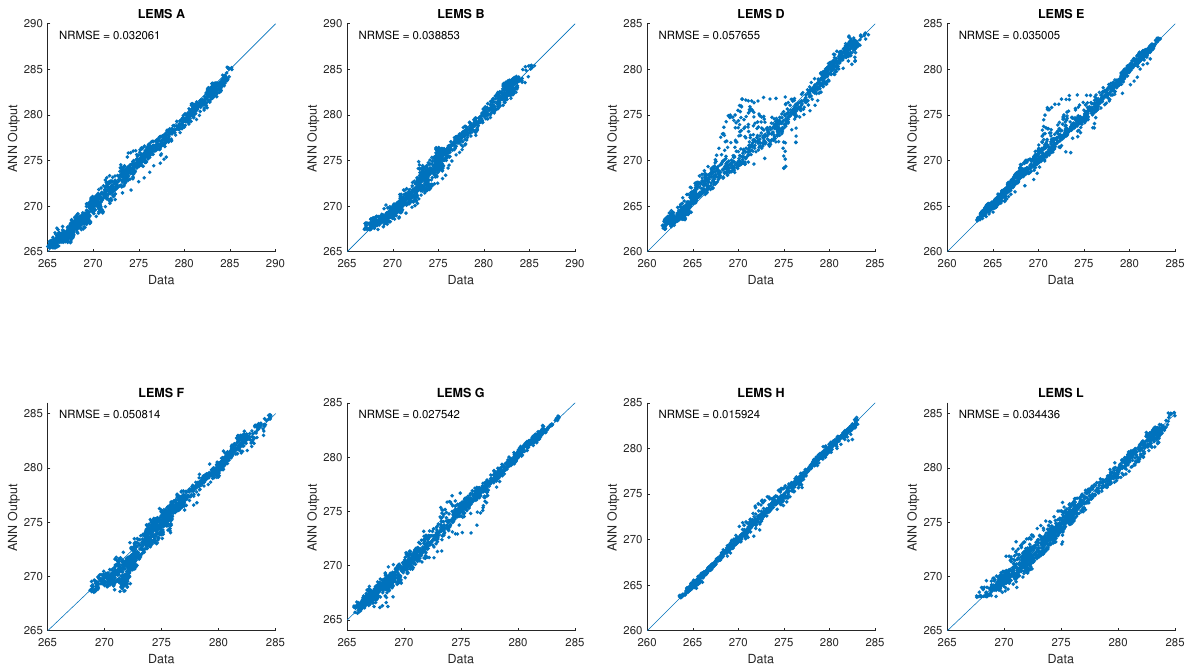
Figure A2. Scatter plots for the ANN prediction of virtual potential temperature for the 15